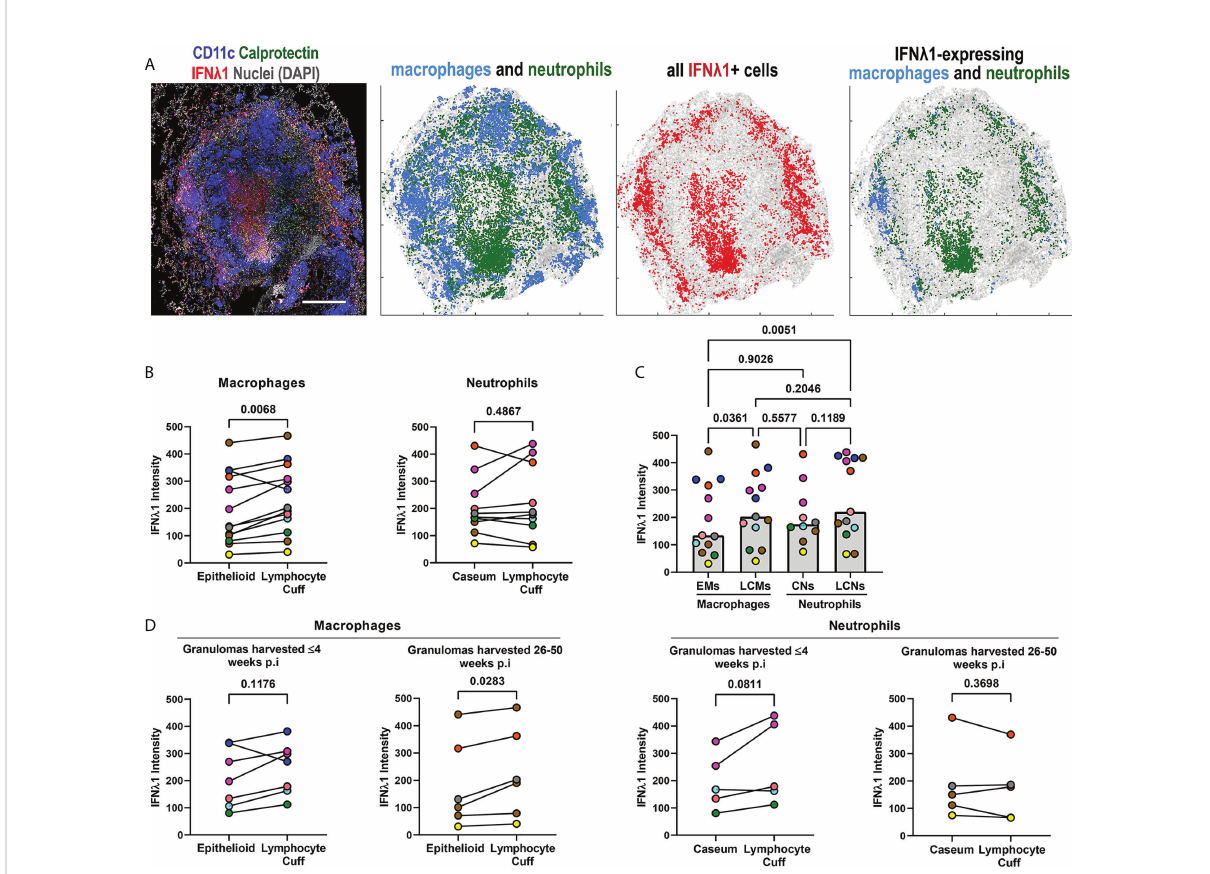
FIGURE 3 IFN l 1 expression varies by granuloma microenvironment. (A) A representative granuloma stained to identify IFN l 1 (red) expressed by CD11c+ macrophages (blue) and calprotectin+ neutrophils (green). Scale bar represents 500 m m. Spatial distribution of macrophages (blue) and neutrophils (green) in the granuloma, distribution of IFN l 1 (red), and distribution of IFN l 1+ macrophages (blue) and neutrophils (green). (B) Comparison of IFN l 1 expression, as measured by median fl uorescence intensity for each cell subset per granuloma, for epithelioid and lymphocyte cuff macrophages (n=13) (left), and caseum and lymphocyte cuff neutrophils (n=10) (right). Statistical comparisons by paired t test. (C) Comparison of median IFN l 1 intensity in epithelioid macrophages, lymphocyte cuff macrophages, caseum neutrophils, and lymphocyte cuff neutrophils (n=13 granulomas). A mixed effect test used to account for repeated measures and pairwise groups compared using Tukey ’ s multiple comparisons test (Tukey adjusted p-values reported). (D) Comparison of IFN l 1 expression, as measured by median fl uorescence intensity, between epithelioid and lymphocyte cuff macrophages (left) in granulomas harvested within 4 weeks post-infection (n=7) or 26-50 weeks post-infection (n=6). A similar comparison of IFN l 1 expression by caseum and lymphocyte cuff neutrophils (right) from granulomas harvested by 4 weeks post-infection (n=5) or between 26-50 weeks post-infection (n=5). Statistical comparisons by paired t